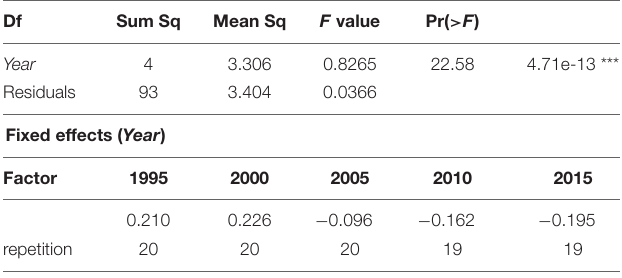
Table of Tukey multiple comparisons of means (Tukey HSD, test = adjusted (type = "Bonferroni") for ANOVA model: log ( OW/FL ) ∼ Year